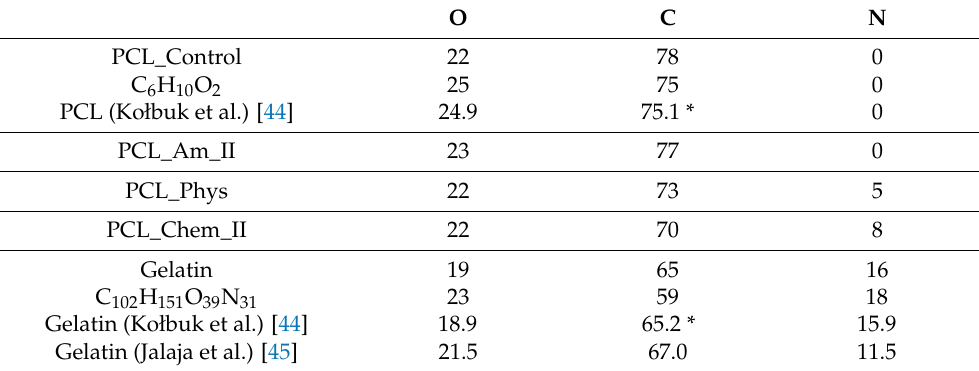
Table 3. Atomic concentrations (atom-%) of oxygen, carbon and nitrogen for PCL and gelatin samples.